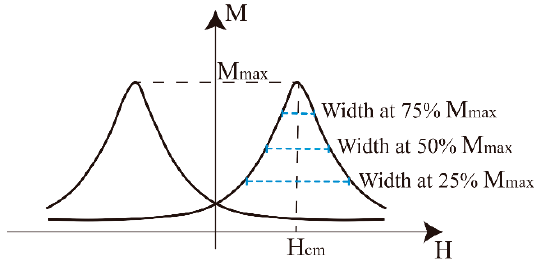
Figure 2. Illustration of full width at 25, 50 and 75% of the maximum amplitude.